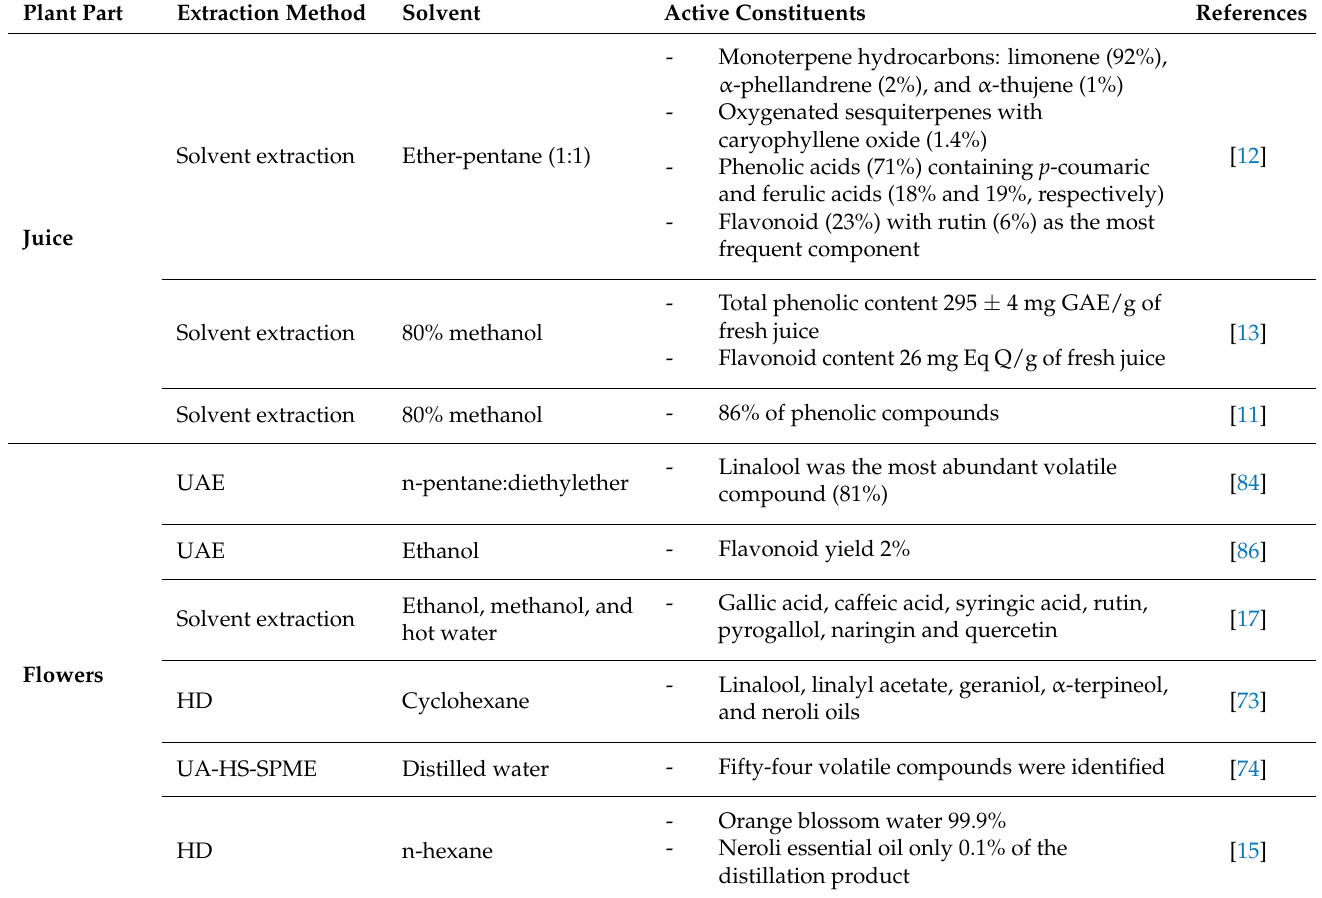
Table 1. Extraction methods and active constituents of the different parts of C. aurantium plant. Plant